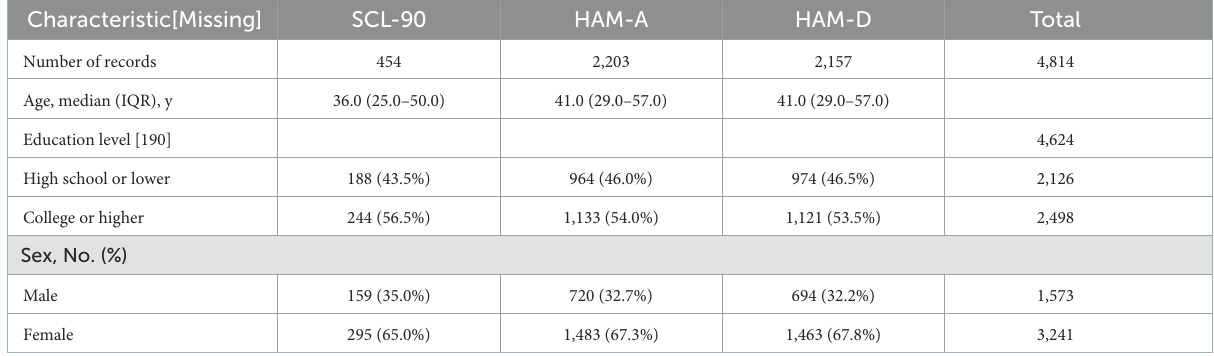
TABLE 1 Demographic characteristics.